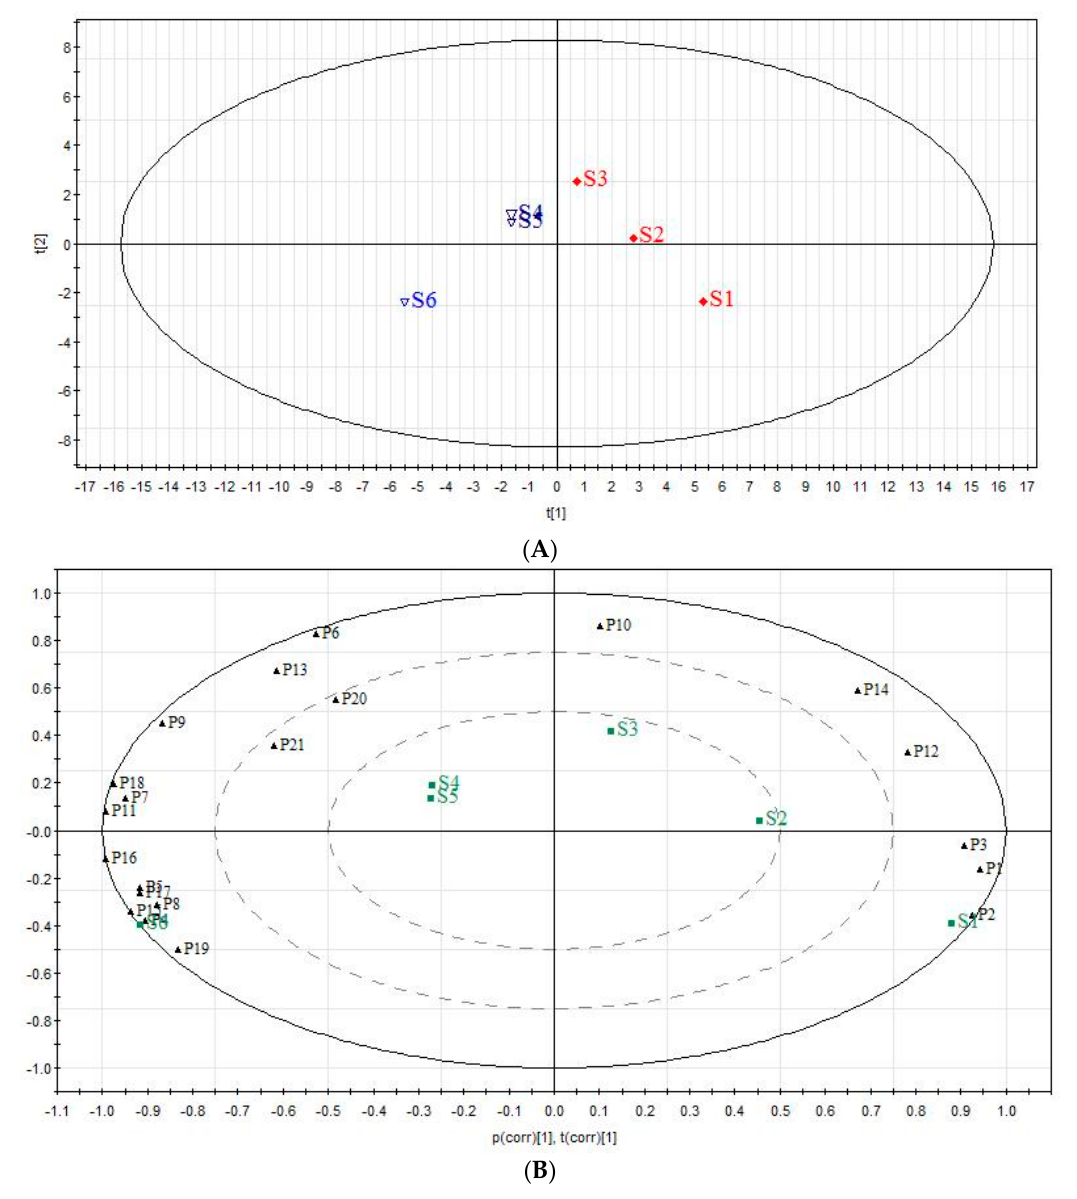
Figure 8. PCA score plot ( A ) and biplot ( B ) of six QBD extracts.